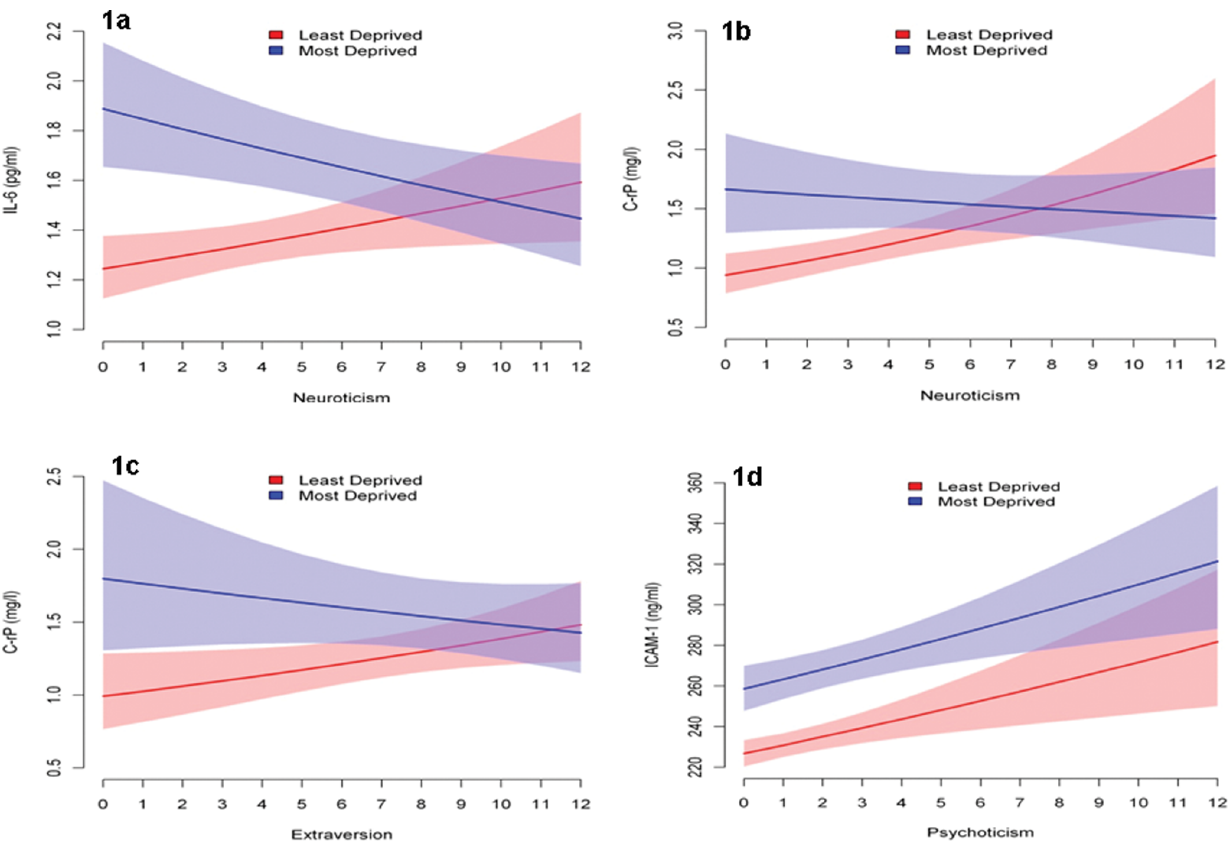
Figure 1. Levels of inflammatory markers as a function of the interaction between personality and deprivation group with 95% confidence bands.